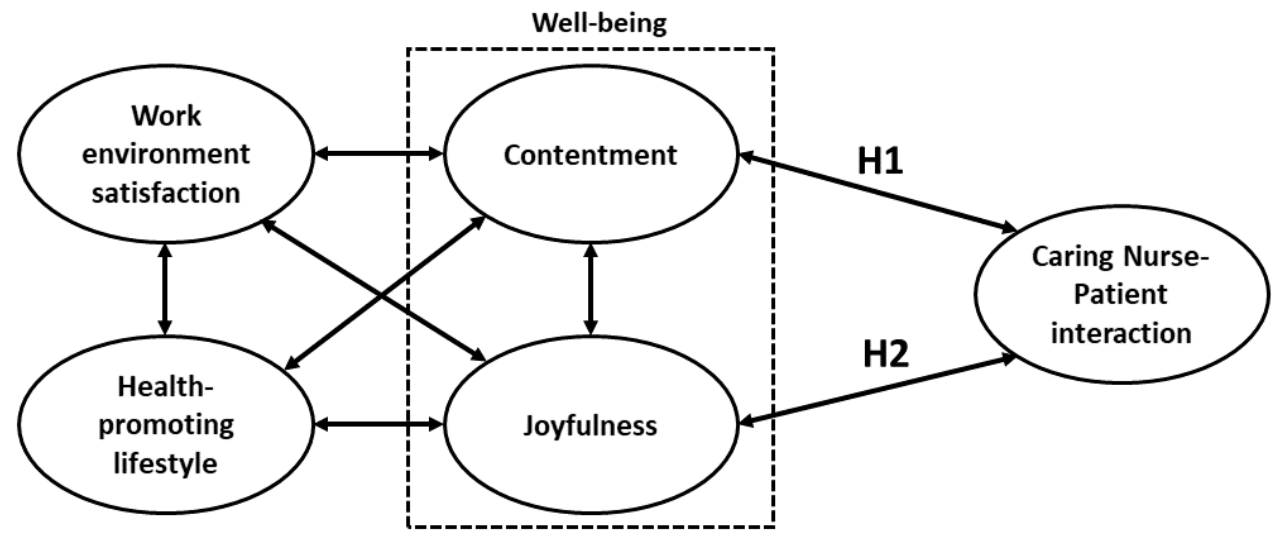
Figure 1. Hypothetical model of nurses’ well-being vs. CNPI competence. The part on the left of H 1 and H 2 is the WHS model proposed by Chung et al. [12].